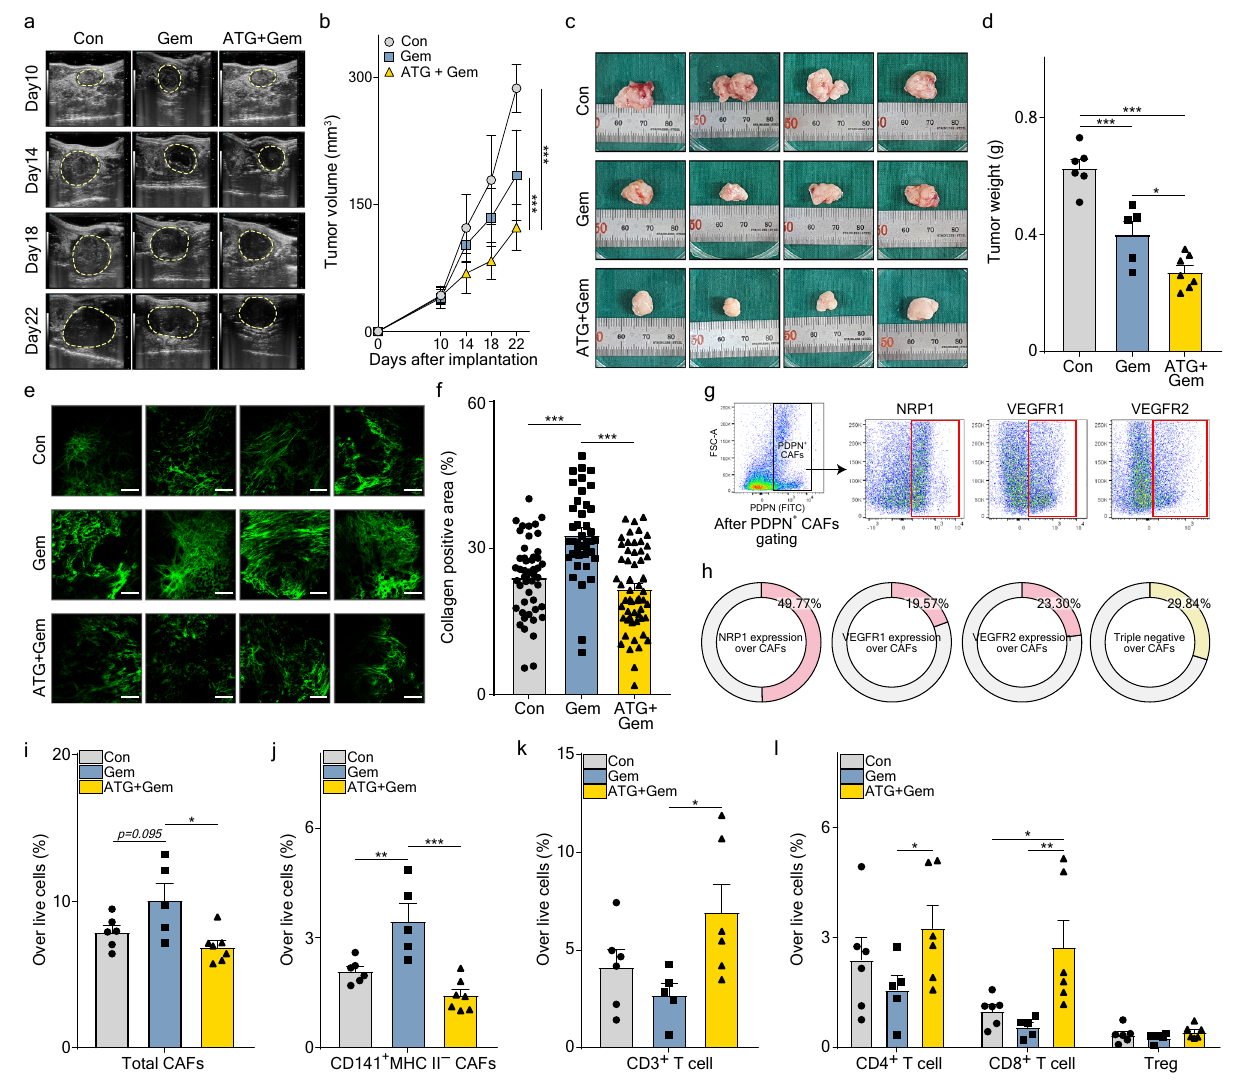
Fig. 8 | Ate-Grab showed comparable therapeutic ef fi cacy between KRAS - mutated murine PDAC and KRAS-wild type murine PDAC. a Representative ultrasonographic images for orthotopic KPC tumor growth in vivo. Con, control; Gem, gemcitabine; ATG+Gem, Ate-Grab and gemcitabine cotreatment. b Tumor volumes compared across indicated treatment groups (Con, n =6; Gem, n =5; ATG+Gem, n =7). *** P <0.001; two-way ANOVA with Tukey ’ s multiple compar- isons. c Representative images of KPCtumors. Ruler scale, 1mm. d Tumor weights compared across indicated treatment groups (Con, n =6; Gem, n =5; ATG+Gem, n =7). Data are presented as the mean±SEM. * P <0.05 ( P =0.030), *** P <0.001, one-wayANOVAwith Tukey ’ s multiple comparisons. e Representative SHG images of KPC tumors from each treatment group. Scale bars, 100 μ m. f Average percen- tages of collagen + area out of total area in tumors. Data from randomly selected fi eldsofviewwereanalyzed(Con, n =48;Gem, n =40;ATG+Gem, n =56).Dataare presented as the mean±SEM. *** P <0.001, one-way ANOVA with Tukey ’ s multiple comparisons. g Flow cytometry gating strategy to evaluate VEGF-related receptor expression in KPC tumor-in fi ltrated CAFs. Cells gated in red box were considered